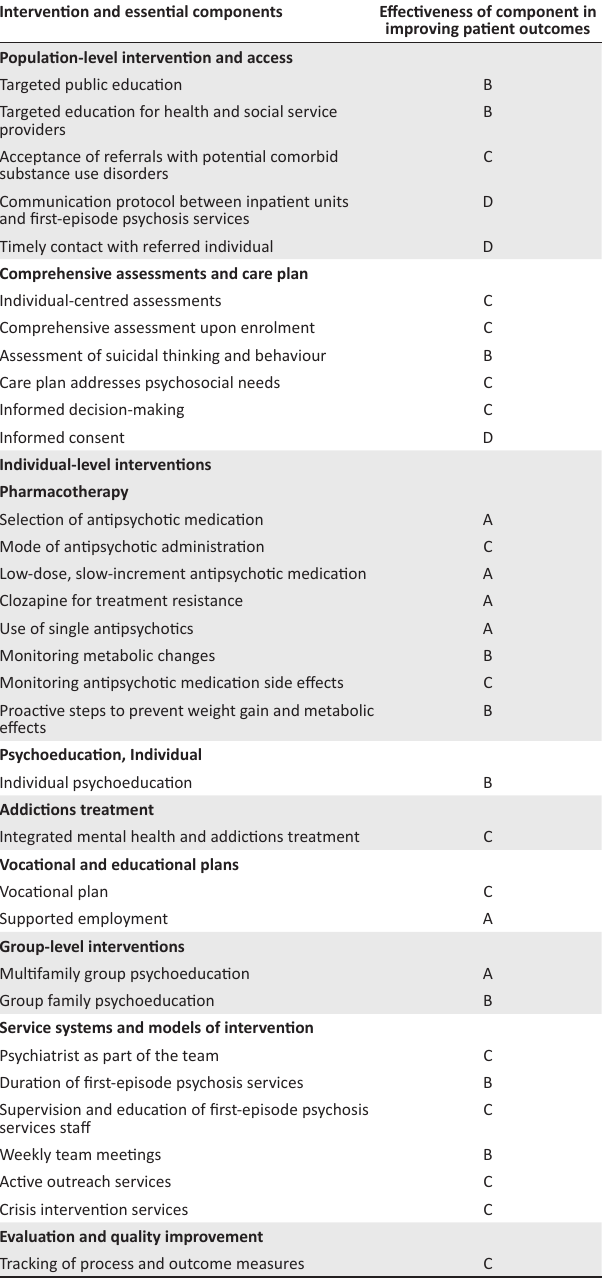
TABLE 1: Description and strength of essential components for early intervention